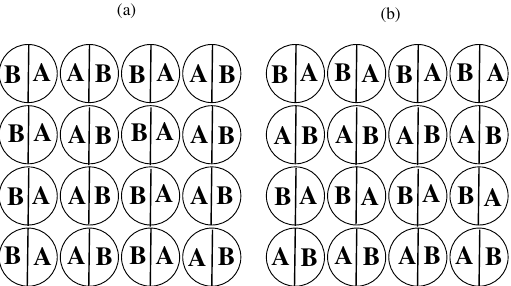
Figure 2. A single plane of the SAF ( a ) and the AF ( b )